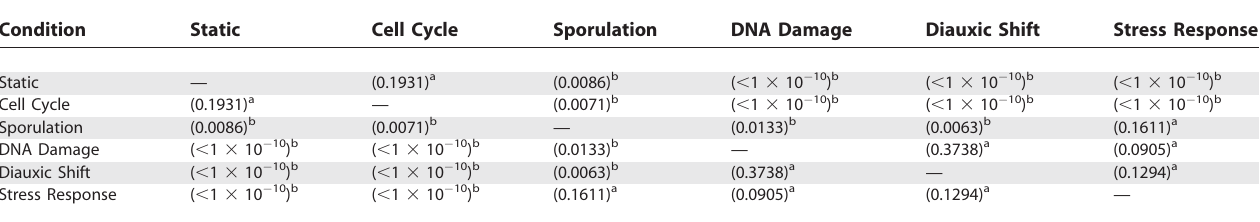
Table 3. Distribution of Normalized Abundances of 3-Vertex Regulatory Subgraph Patterns under Different Conditions Condition